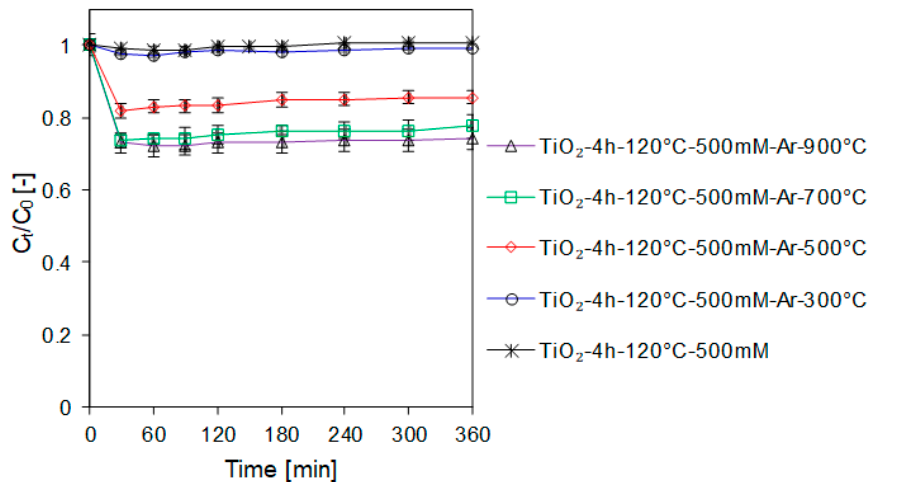
Figure 5. Adsorption degree of methylene blue dye on the surface of APTES-modified TiO 2 before and after calcination.